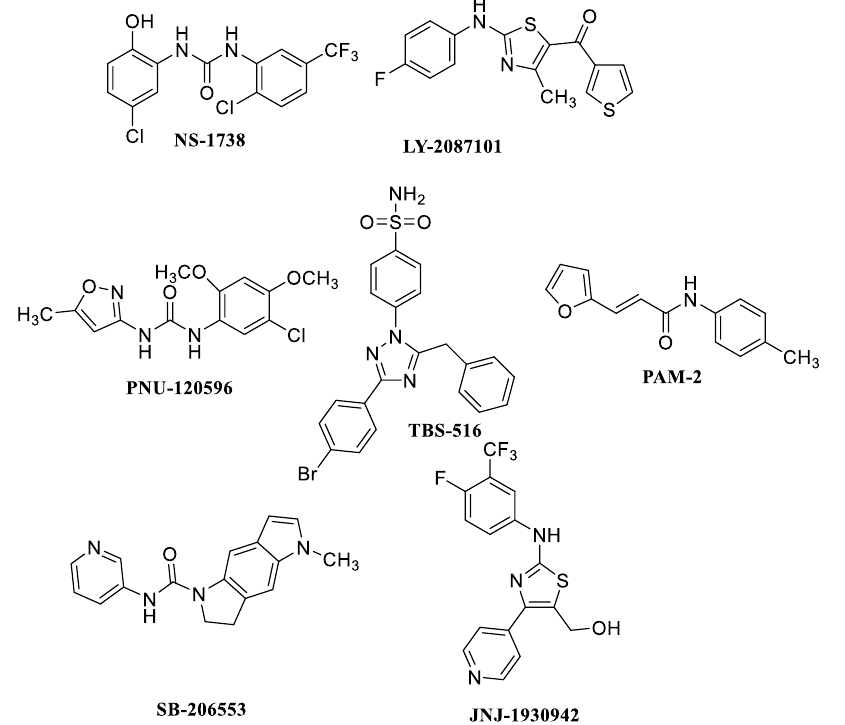
Figure 1. Examples of type I, type II and type I/type II intermediate α 7-positive allosteric modulators (PAMs).